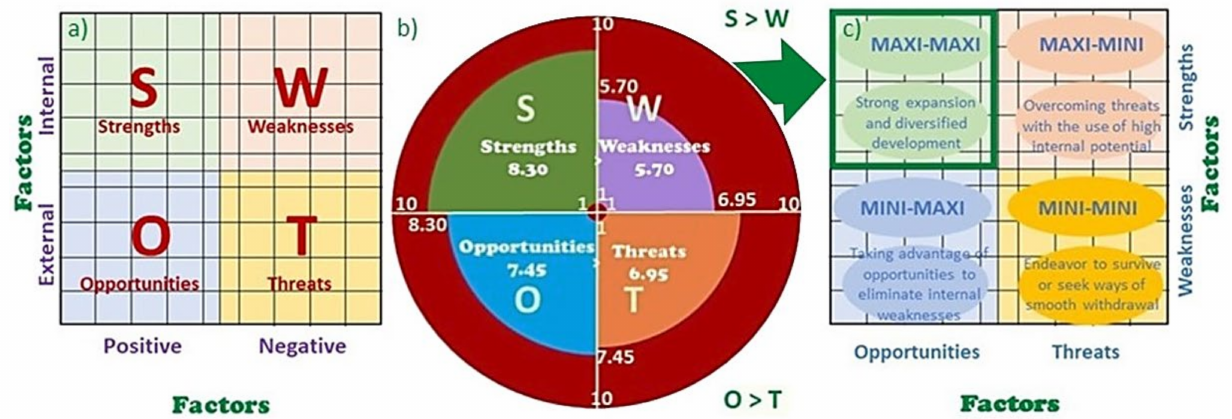
Figure 6. Contextual matrices: ( a ) scheme general basis of the SWOT (strengths-weaknesses-opportunities-threats) analysis; ( b ) a diagram of the results of the SWOT analysis for gutta-percha filling material with numerical representation of individual aspects of the assessment indicating the advantage of strengths and opportunities (the field area corresponds to the numerical rating of each analysis factor); ( c ) a diagram of choosing the MAXI-MAXI strategy from among four possible concerning the filling material based on gutta-percha because S > W and O >